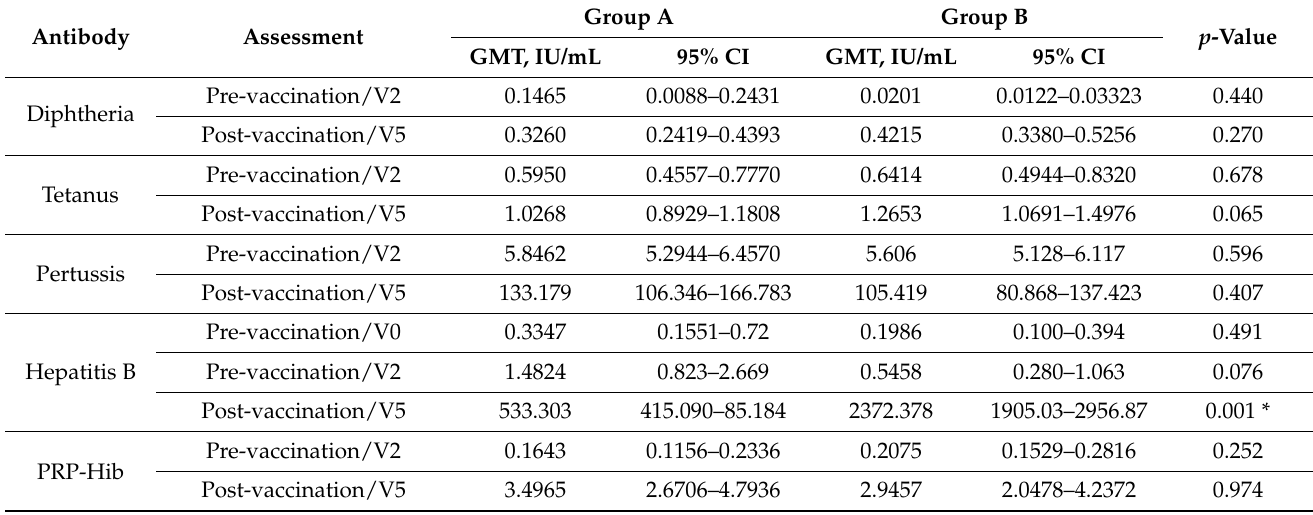
Table 5. Summary of geometric mean antibody titers (per-protocol immunogenicity